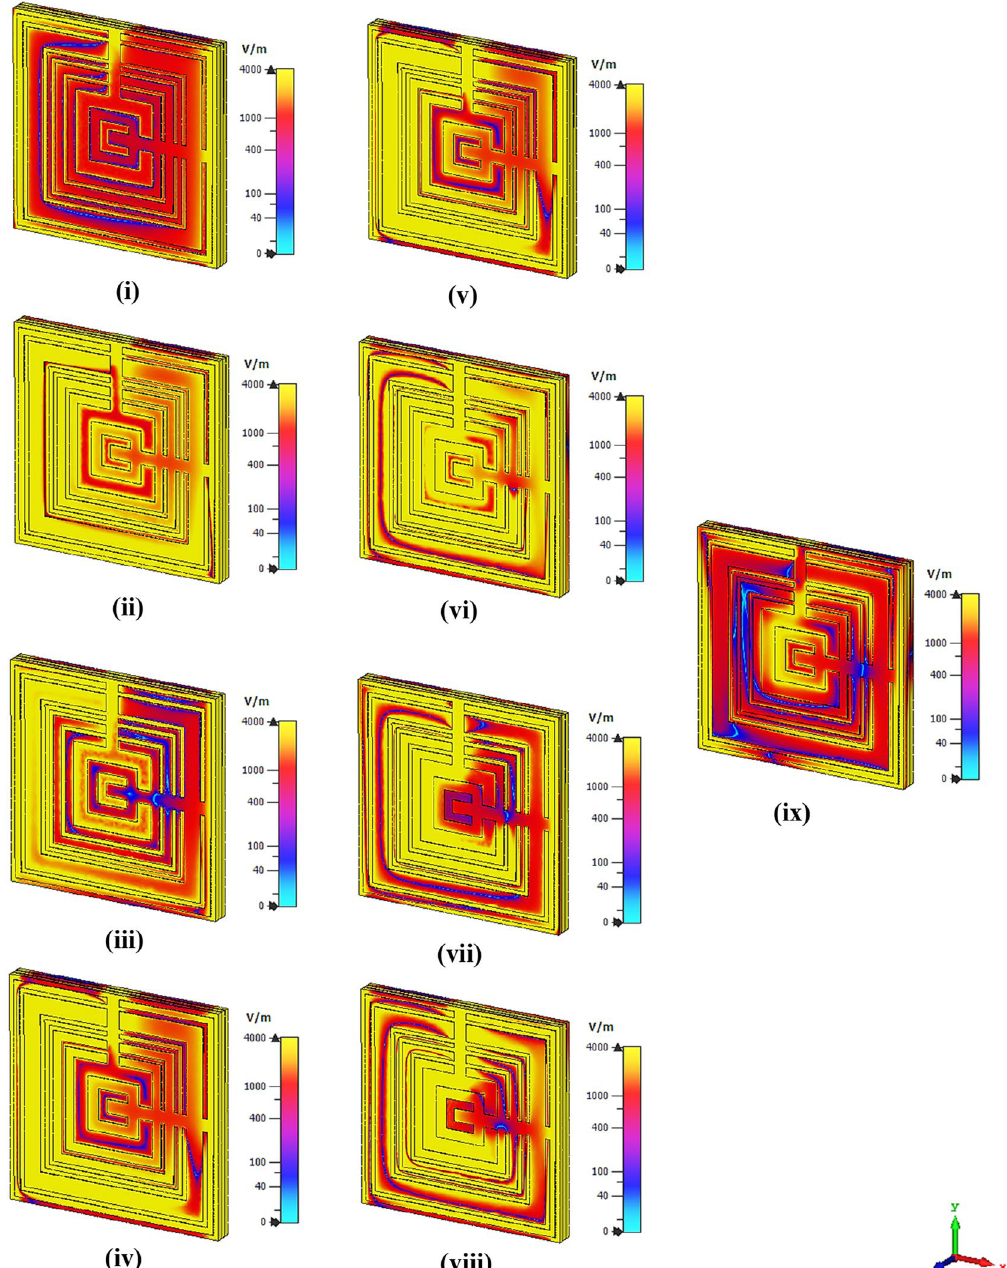
Figure 4. Absolute electric field distribution of the proposed MSM design at; (i) 1.2 GHz, (ii) 1.458 GHz, (iii) 1.56 GHz, (iv) 1.896 GHz, (v) 2.268 GHz, (vi) 2.683 GHz, (vii) 2.940 GHz, (viii) 3.580 GHz, (ix) 5.872